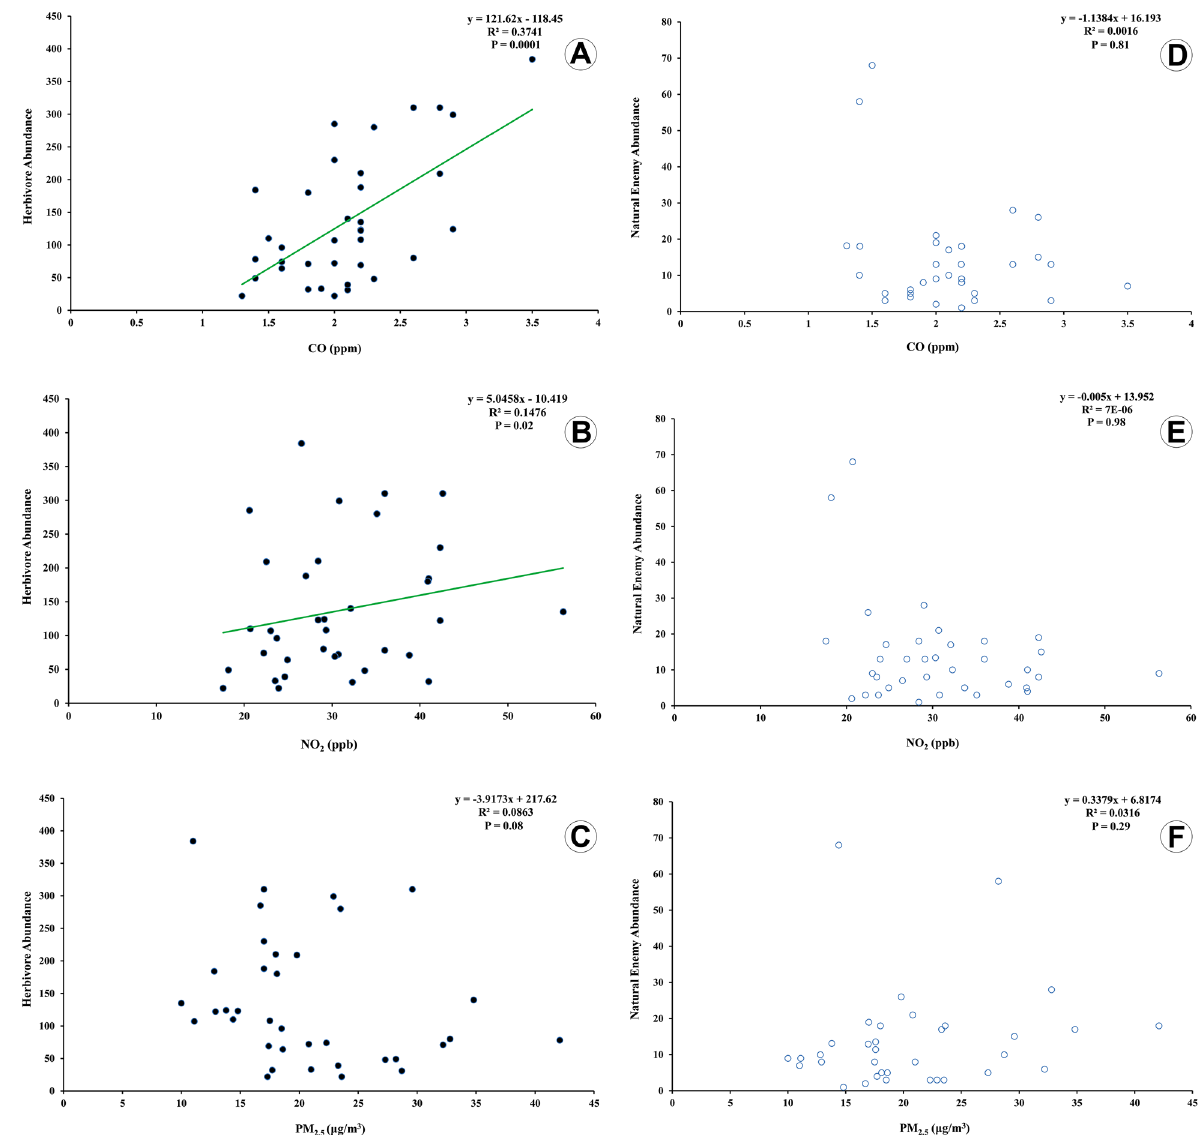
Figure 7. Abundance regression of insect fauna associated with Chinese thuja trees, Platycladus orientalis (L.) with three air pollutant concentrations in urban green spaces of Mashhad city from Iran. Herbivores ( A – C ). Natural enemies ( D – F ). CO ( A, D ). NO 2 ( B, E ). PM 2.5 ( C, F ).